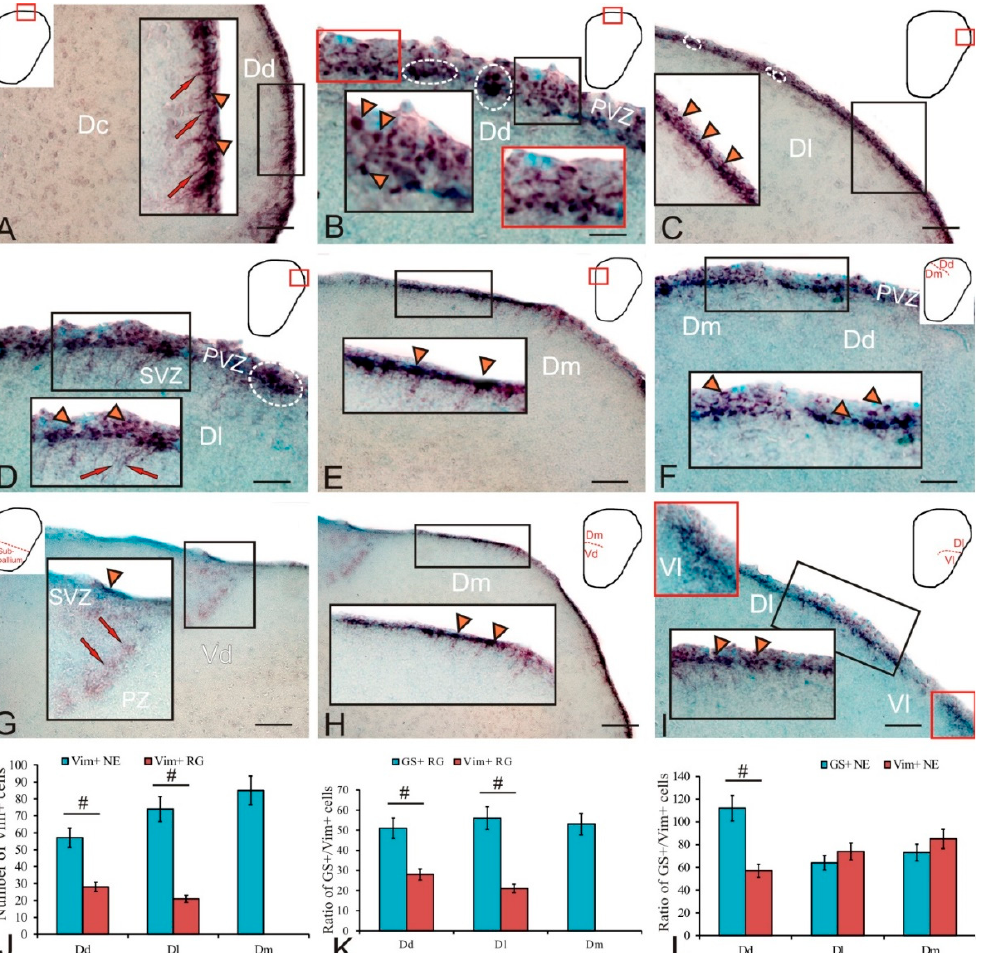
Figure 5. Vimentin (Vim) in the pallial and subpallial regions of the telencephalon in trout, On- corhynchus mykiss : ( A ) immunolabeling of vimentin in PVZ (inset), Vim+ NE cells (orange arrow- heads), and RG (red arrows) forming a monolayer; ( B ) Vim in Dd of pallium in small NE intensely labeled cells (insets) and constitutive clusters in the basal part of the PVZ (white dotted ovals), Vim+ NE cells (orange arrowheads); ( C ) Vim+ cells (orange arrowheads) in extensive clusters (inset) in Dl forming small dense groups (white dashed ovals); ( D ) Dl sectors (inset) containing RG (red arrows) (other designations, as in ( B )); ( E ) Vim+ NE type cells in PVZ (inset), forming a monolayer in Dm; ( F ) a border zone between Dd and Dm (inset), with a lower density of Vim+ NE cells; ( G ) low Vim immunopositivity in the dorsal subpallium of Vd (inset), weakly labeled NE cells (red arrows), and Vim+ granules in the PVZ (orange arrowhead); ( H ) border between Dm and Vd and labeled NE cells (arrowheads) in Dm (inset); ( I ) border between Dl and Vl, clusters of Vim + cells in Dl (black inset), and a single aggregation of Vim+ cells of NE type (red inset). Scale bars: ( A , C , E , G – I ) 100 µm and ( B , D , F ) 50 µm. ( J ) A comparative distribution of Vim+ RG and NE cells in trout pallium, with significant intergroup differences in the number of cells in Dd and Dl, # ( p < 0.05) ( n = 5 in each group), one-way ANOVA; ( K ) a comparative distribution of Vim+ RG and GS+ RG in trout pallium, significant intergroup differences in the number of cells in Dd and Dl, # ( p < 0.05) ( n = 5 in each group), one-way ANOVA; ( L ) a comparative distribution of Vim+ NE and GS+ NE cells in trout pallium, significant intergroup differences in the number of cells in Dd, # ( p < 0.05) ( n = 5 in each group), one-way